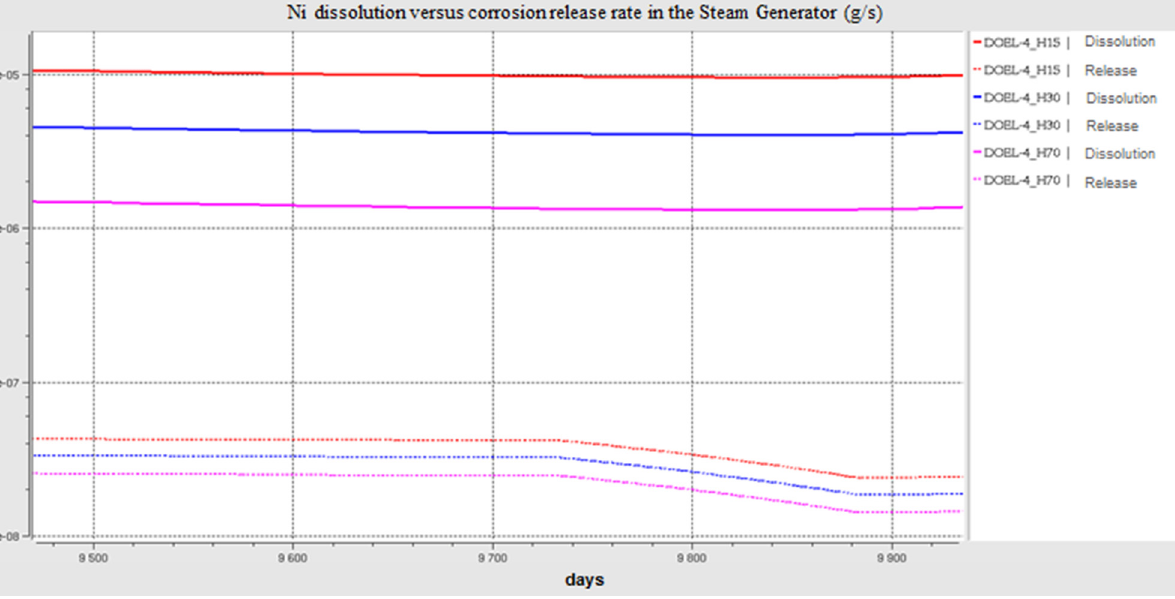
Fig. 11. OSCAR V1.3 calculation – Ni dissolution versus corrosion release rate in the steam generator region for cycle